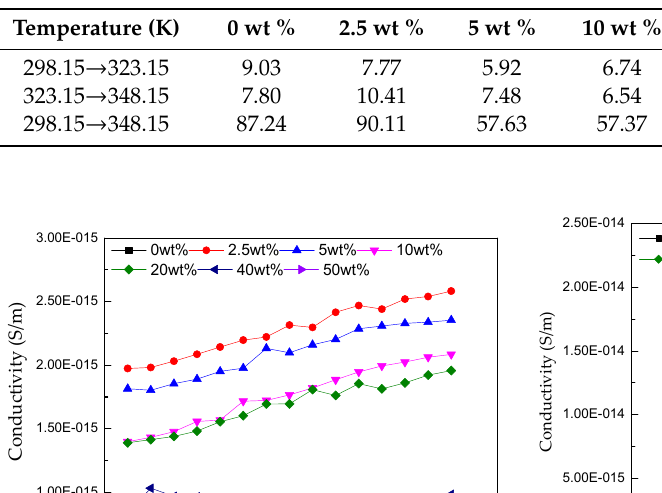
Table 1. α under different temperature changes.